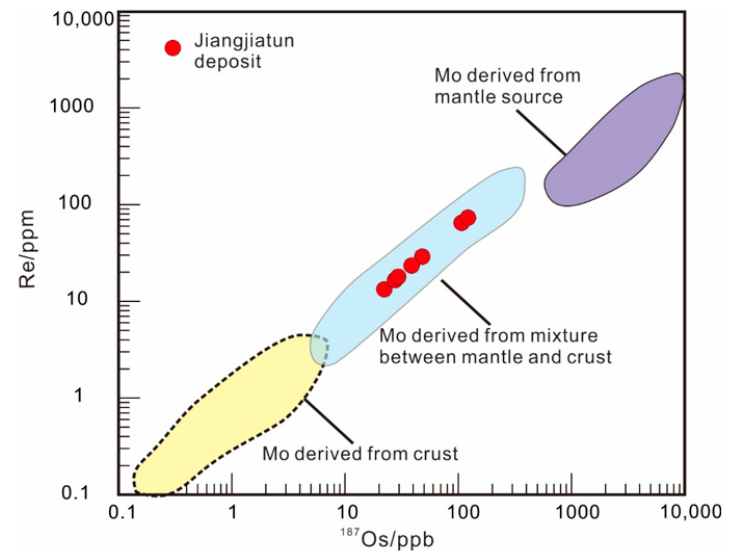
Figure 8. The concentrations of Re vs. 187 Os diagram (modified from [1]) for the Jiangjiatun Mo deposit.